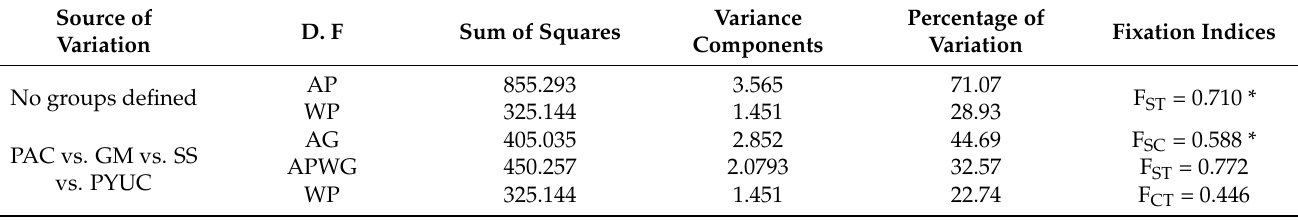
Table 1. Analysis of molecular variance using mtDNA control region; no groups defined and between groups (Pacific, Gulf of Mexico, San Sebastian, and Yucatan Peninsula).